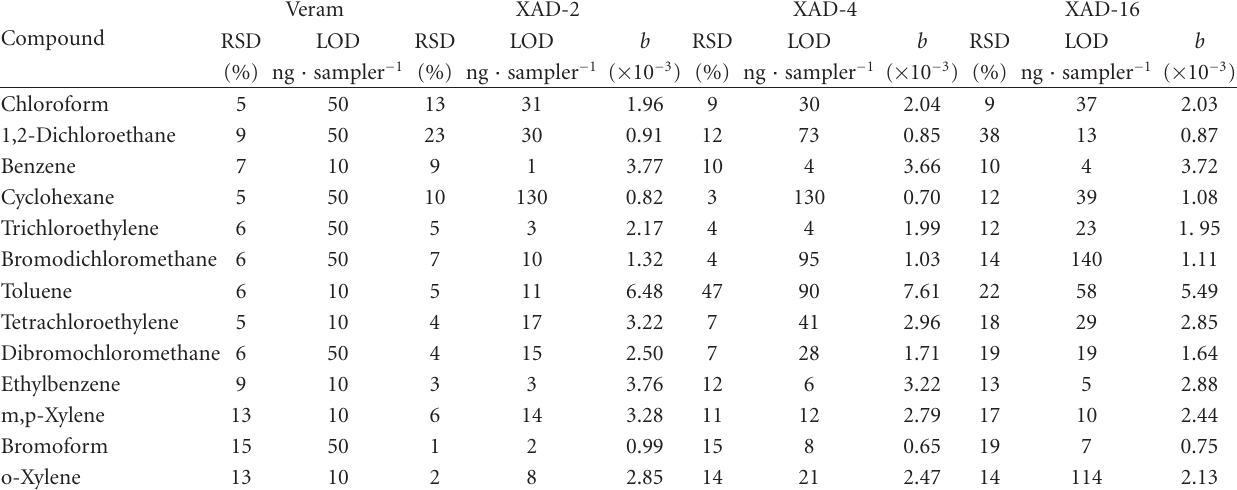
Table 4: Analytical features of HS-GC-MS determination of studied VOCs for each adsorbent evaluated. Veram XAD-2 Compound RSD LOD RSD